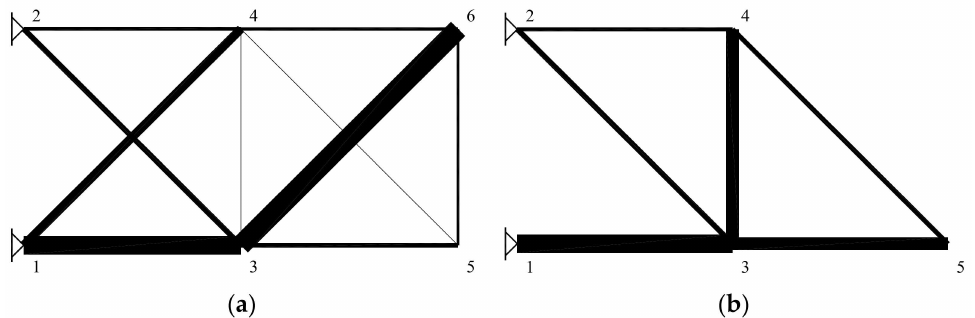
Figure 11. Optimal solutions, example TC10c (topology optimization, with buckling constraints).